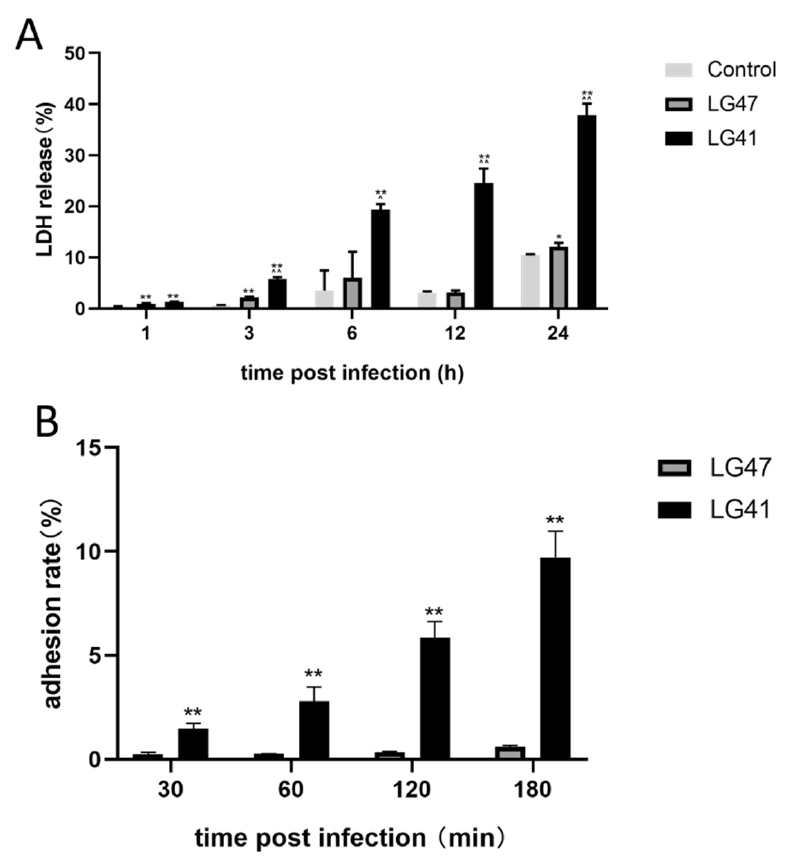
Figure 6. In vitro pathogenic effects of L. garvieae on bovine mammary epithelial cells (MAC-T). ( A ) Effects of L. garvieae isolates (LG41 and LG47) on lactate dehydrogenase release of MAC-T. Data are mean ± SD of three independent experiments. * indicates a significant difference between different treatment groups ( p < 0.05 by ANOVA test), and ** indicates a very significant difference between different treatment groups ( p < 0.01 by ANOVA test). ( B ) Adhesion of L. garvieae (up to 3 h after infection) into MAC-T. ** indicates a very significant difference between different treatment groups ( p < 0.01 by ANOVA test). The bar charts were calculated and plotted using GraphPad prism